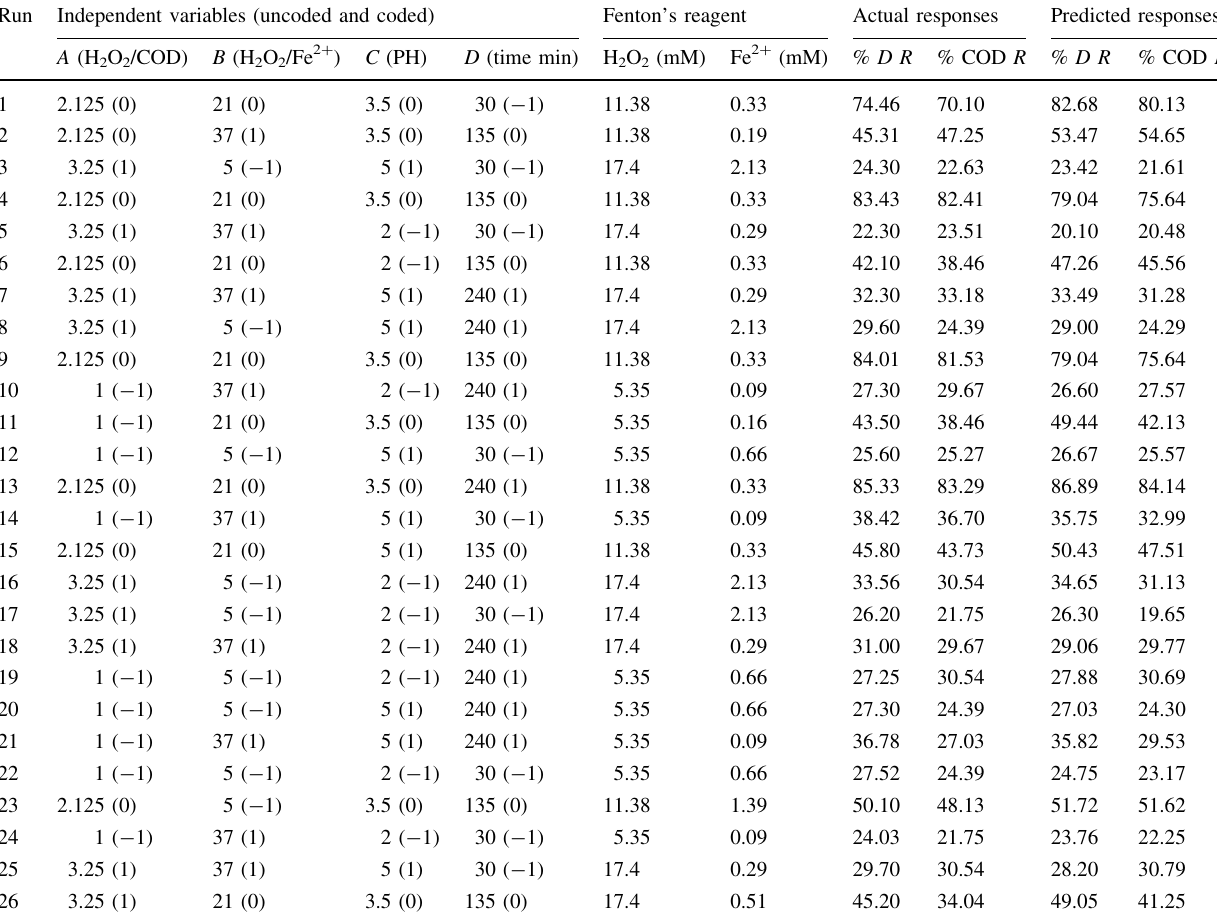
Table 3 CCD design matrix Run Independent variables (uncoded and coded) Fenton’s reagent Actual